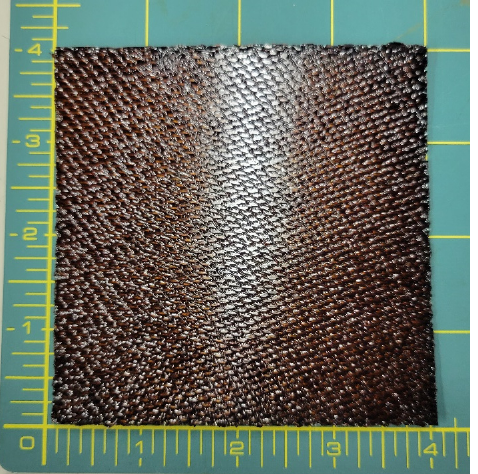
Figure 2. Photograph of a typical 10 cm × 10 cm (4 in × 4 in.) composite sample after post-cure heat treatment for 30 min at 240 °C. Scale units are inches.